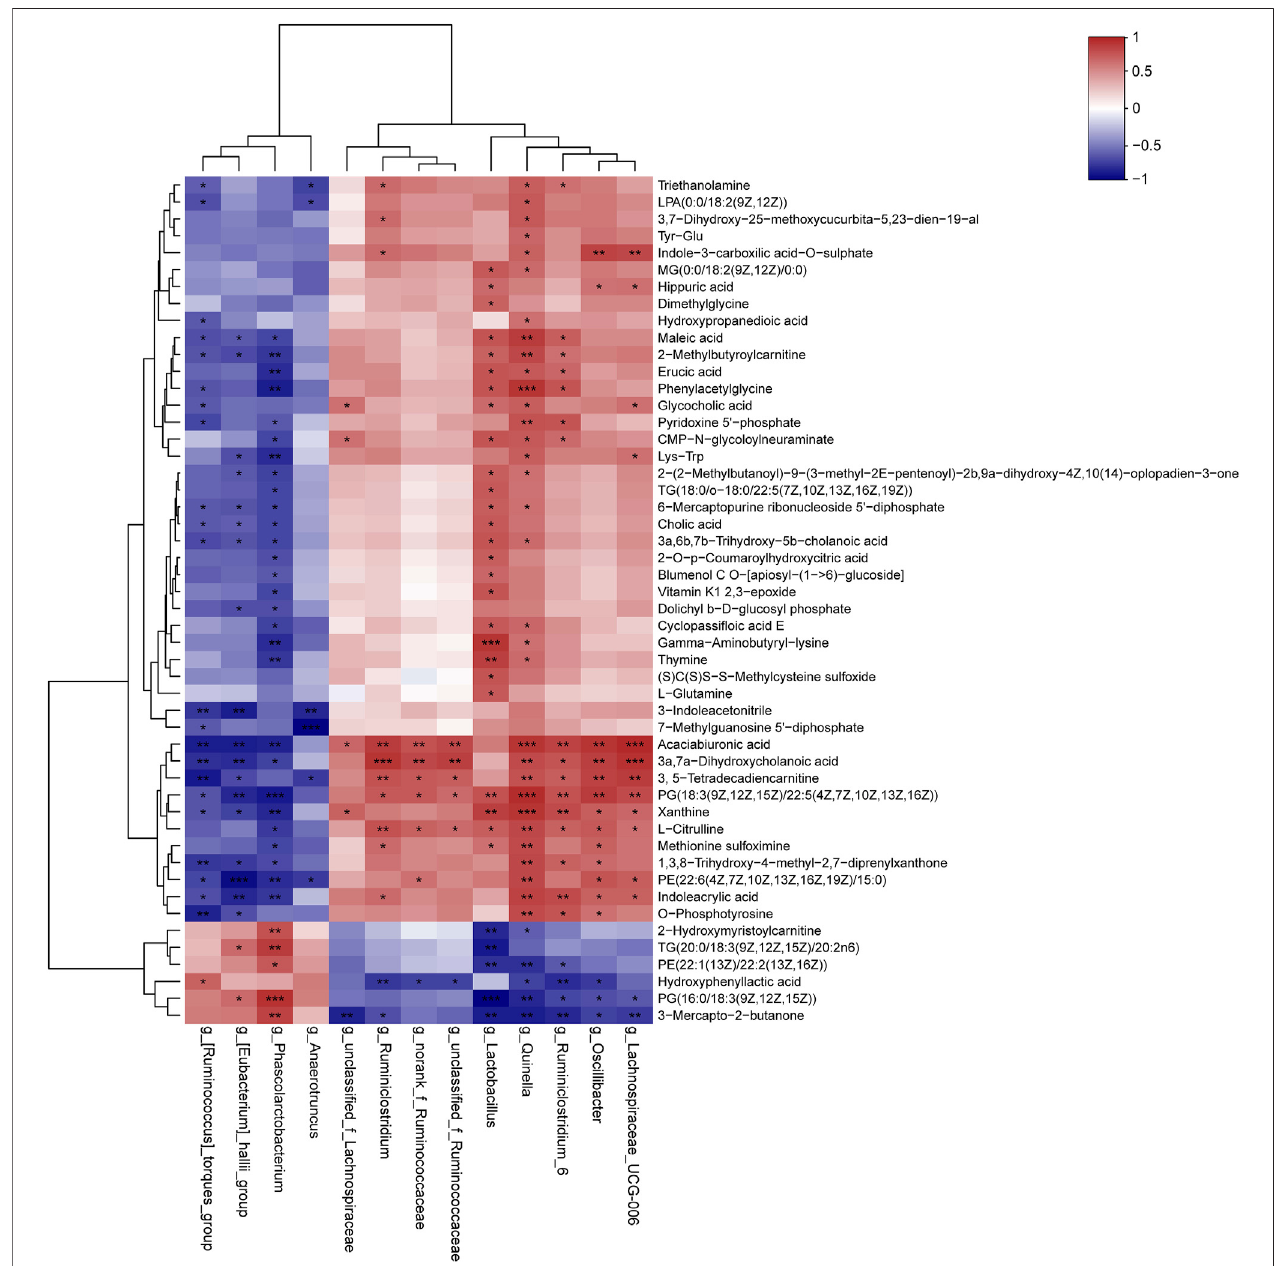
FIGURE 6 | Correlation analysis of the gut microbiome and serum metabolites. The results of Spearman ’ s correlation between 13 differential genera (MET vs. DM) and50differentialmetabolites(METvs.DM)werepresentedasaheatmap.* p < 0.05,** p < 0.01,*** p < 0.001denotedstatisticalsigni fi cancebetweenbacterialtaxaand